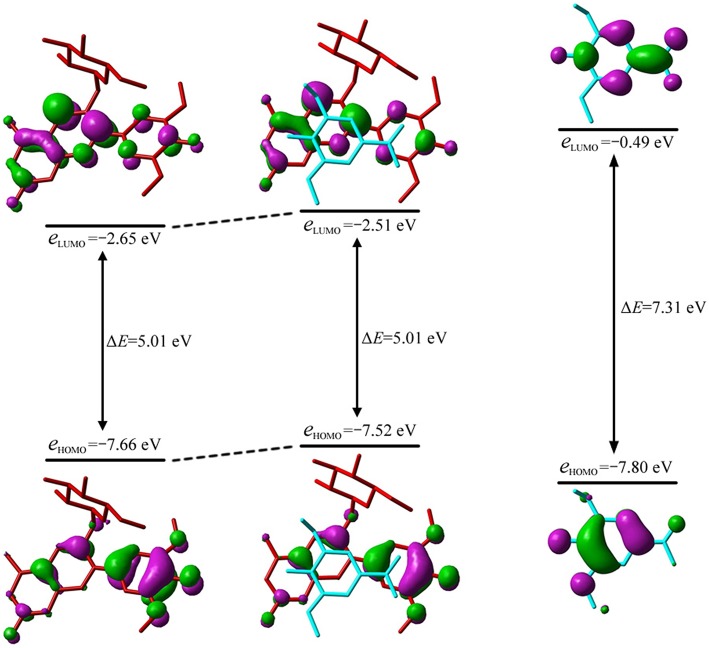
Molecular orbital correlation diagram of oenin, conformer 1 and syringic acid. A tube molecular representation was adopted for oenin (red) and syringic acid (cyan).